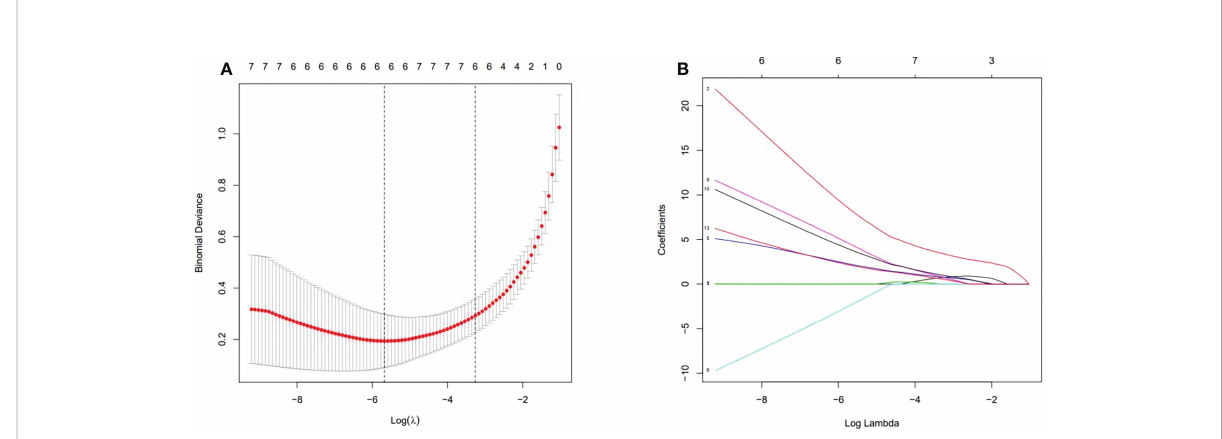
FIGURE 3 Ultrasonographic feature selection using the least absolute shrinkage and selection operator (LASSO) regression in the training cohort. (A) Lambda ( l ) selection in the LASSO model used 10-fold cross-validation via minimum criteria. The value of l was used to select features. Vertical lines were drawn at the optimal values using the minimum criteria and the 1-SE criteria. The optimal value of 0.0034 was selected. (B) Coef fi cient pro fi les of the 13 features.